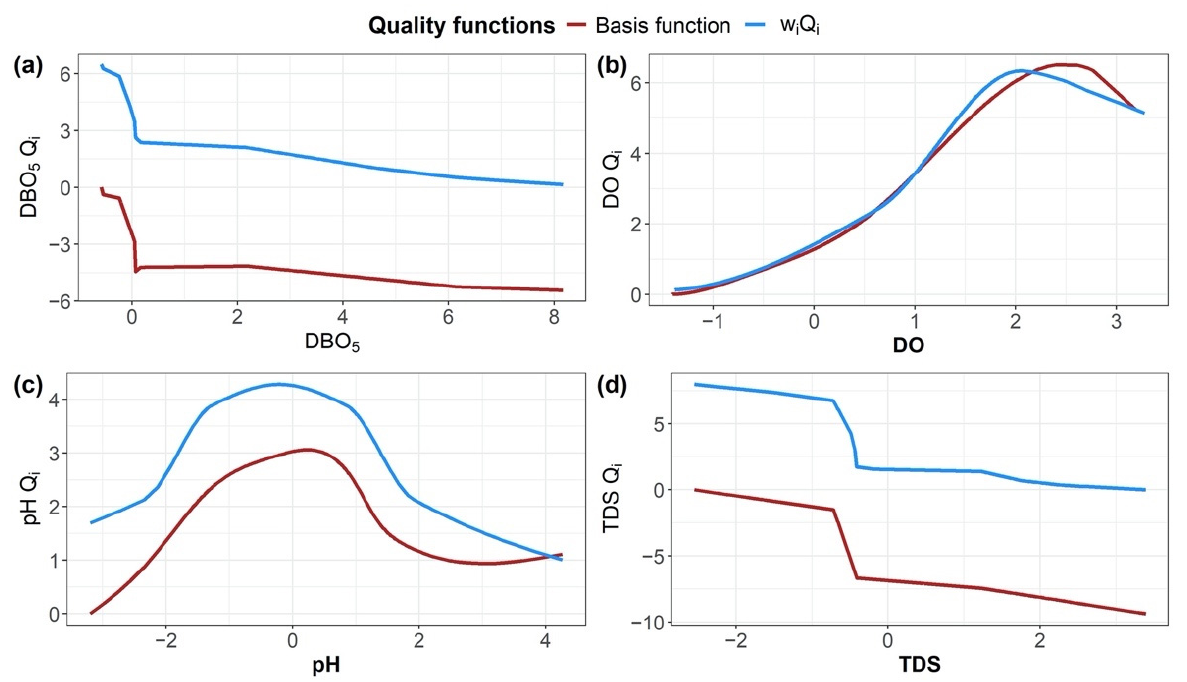
Figure 12. Comparison of the weighted rating curve (WiQi) developed for WQI calculation by Casillas-García et al., (2021) [20], marked in blue, and the base functions obtained by the generalized additive model for ( a ) BOD 5 , ( b ) DO, ( c ) pH, and ( d ) TDS, marked in red.